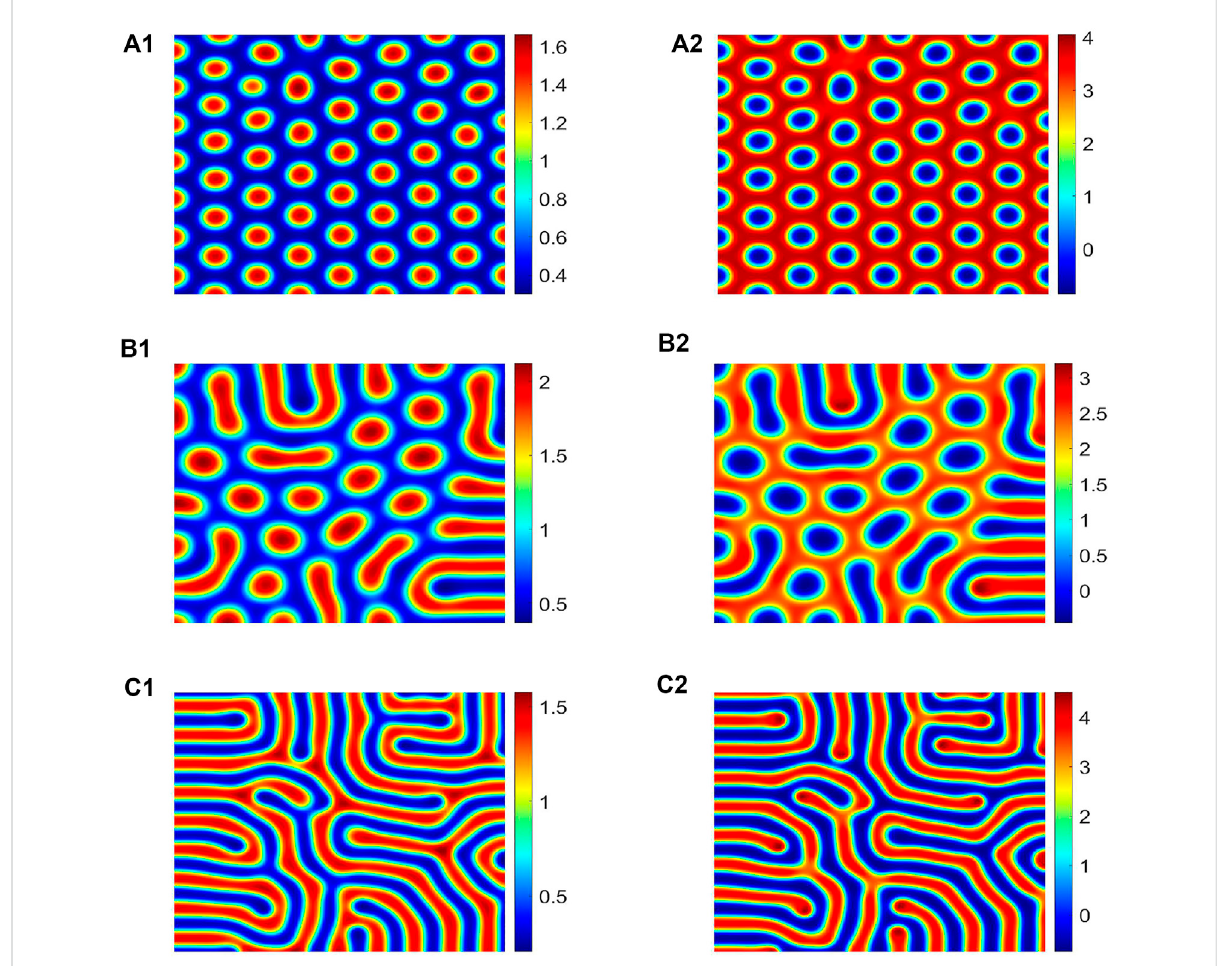
FIGURE 4 For different pattern structures, the parameter values are shown in Table 3. ( a 1 )-( c 1 ) is the water pattern, and ( a 2 )-( c 2 ) is the vegetation pattern. Among them, ( a 1 ) and ( a 2 ) are spot patterns, ( b 1 ) and ( b 2 ) are mixed patterns, and ( c 1 ) and ( c 2 ) are strip